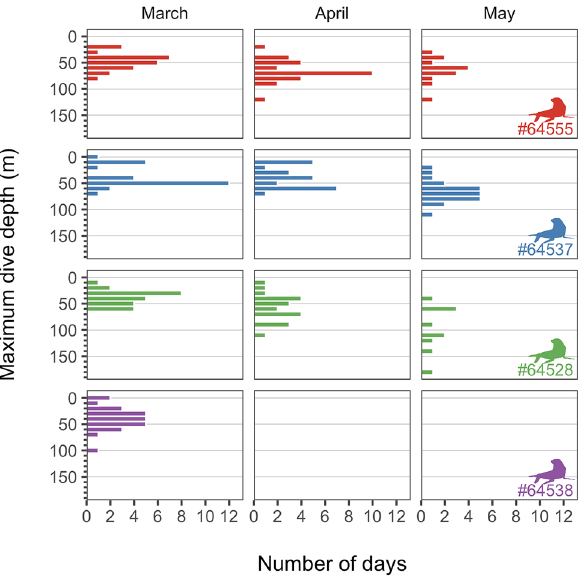
Figure 4. Daily maximum depth of four juvenile male Antarctic fur seals instrumented with depth sensors.